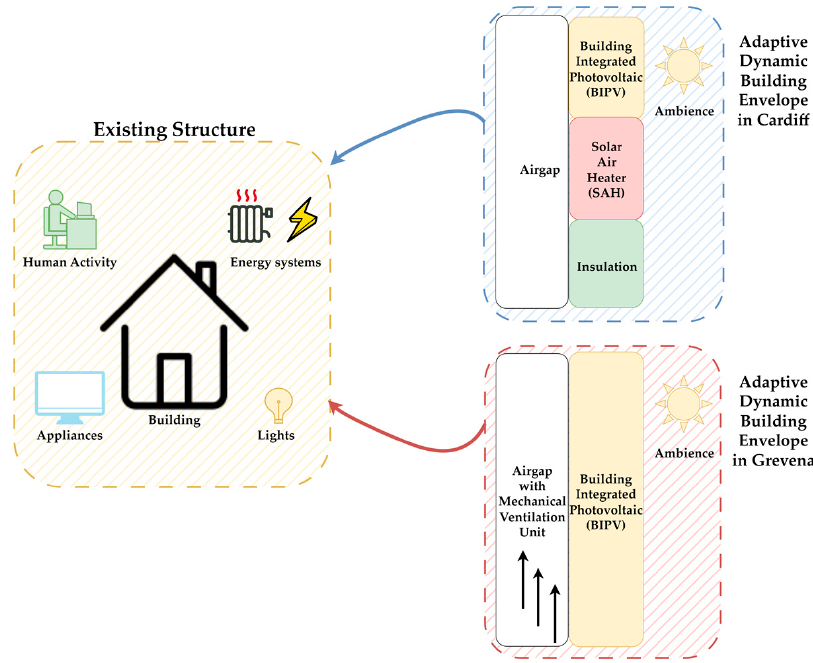
Figure 1. Graphical representation of both ADBE designs under study.